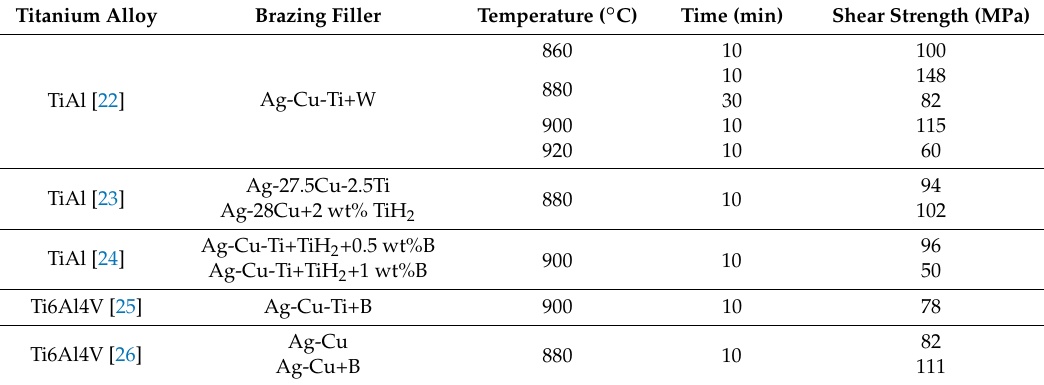
Table 1. Brazing conditions and shear strength values of titanium alloys and Al 2 O 3 joints.